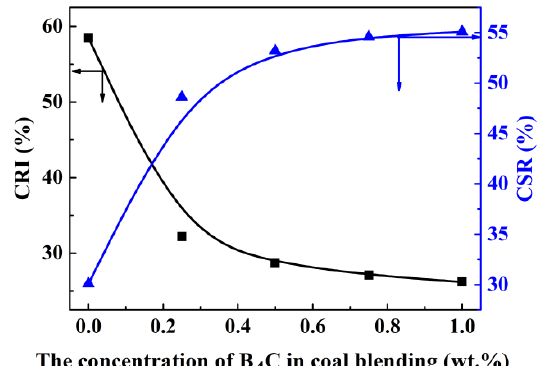
Figure 1. The relationship between thermal strength indexes of coke and the concentration of B 4 C in coal blending. CRI: coke reactivity towards CO 2 ; CSR: coke strength after